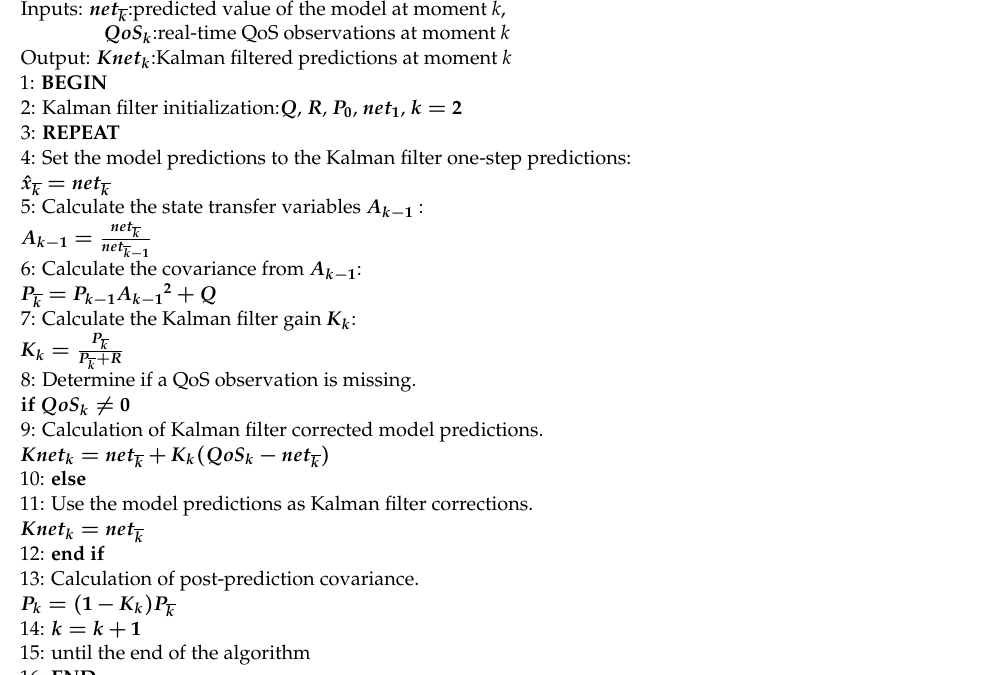
Algorithm 3: Kalman filter-based deep learning prediction correction algorithm under sparse